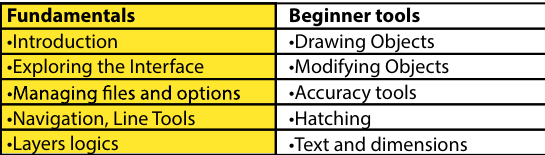
Figure 1: Self-directed learning model (Singapore Polytechnic, 2018) Source: Department of Educational Development, Singapore Polytechnic